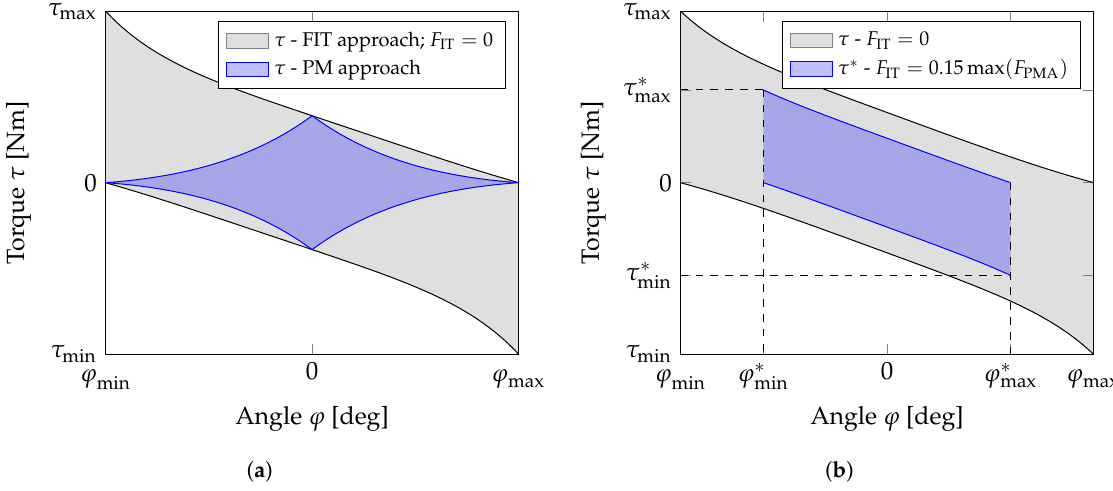
Figure 4. Torque characteristics of a PMA-driven joint for two different pressure generation laws. ( a ) gray: torque “FIT-approach” and F IT = 0; blue: “PM-approach”. ( b ) gray: torque “FIT-approach” and F IT = 0; blue: torque “FIT-approach” and F IT = 0.15max ( F PMA )